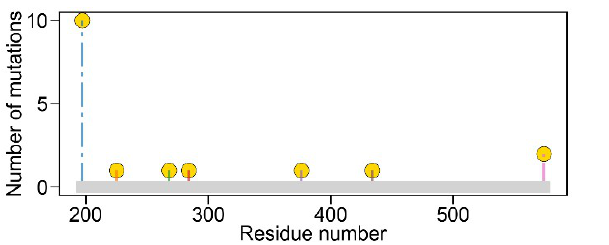
Fig 1. Reported mutation sites in Kochia scoparia AHAS ( Ks AHAS). Mutations at four sites (Pro197, Val225, Asp376, and Trp574) confer resistance to sulfonylurea herbicides while mutations at the other three sites (Gly268, Glu284, and Asn434) resulted in susceptibility. Residue numbers refer to the positions in the Arabidopsis thaliana AHAS ( At AHAS) amino acid sequence with which Ks AHAS was aligned.